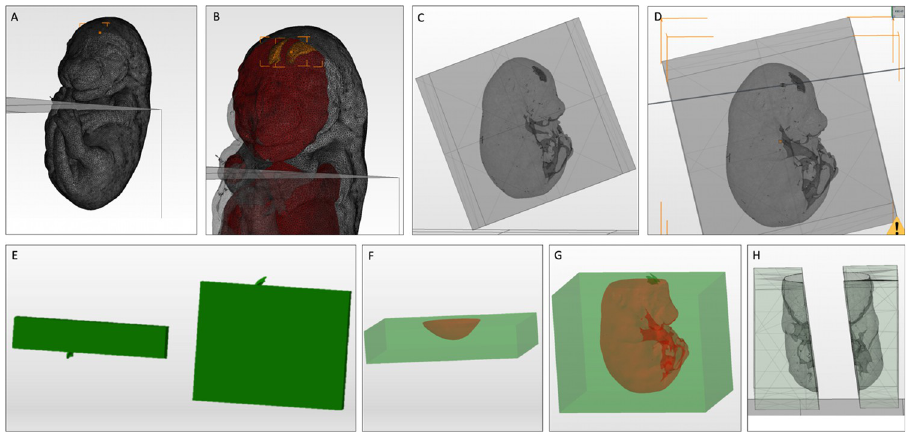
Fig 1. Steps of mold creation from the digital embryo model. (A) Importation of embryo model into Netfabb. (B) Importation of the posterior ventricle into Netfabb. (C) Creation of a box from the part library; it was scaled to cover the embryo model. (D) The plane cut through the box, the embryo model, and the lateral ventricle model. (E) Merging of the upper and lower parts of the lateral ventricle after the plane cut. (F) Subtraction of the head part of the embryo after the plane was cut from the surrounding box with the "Boolean difference" function. (G) Subtraction of the embryo body model after the plane is cut from w the surrounding box with the "Boolean difference" function. (H) Separation of the embryo’s body mold into two halves to create the final silicon